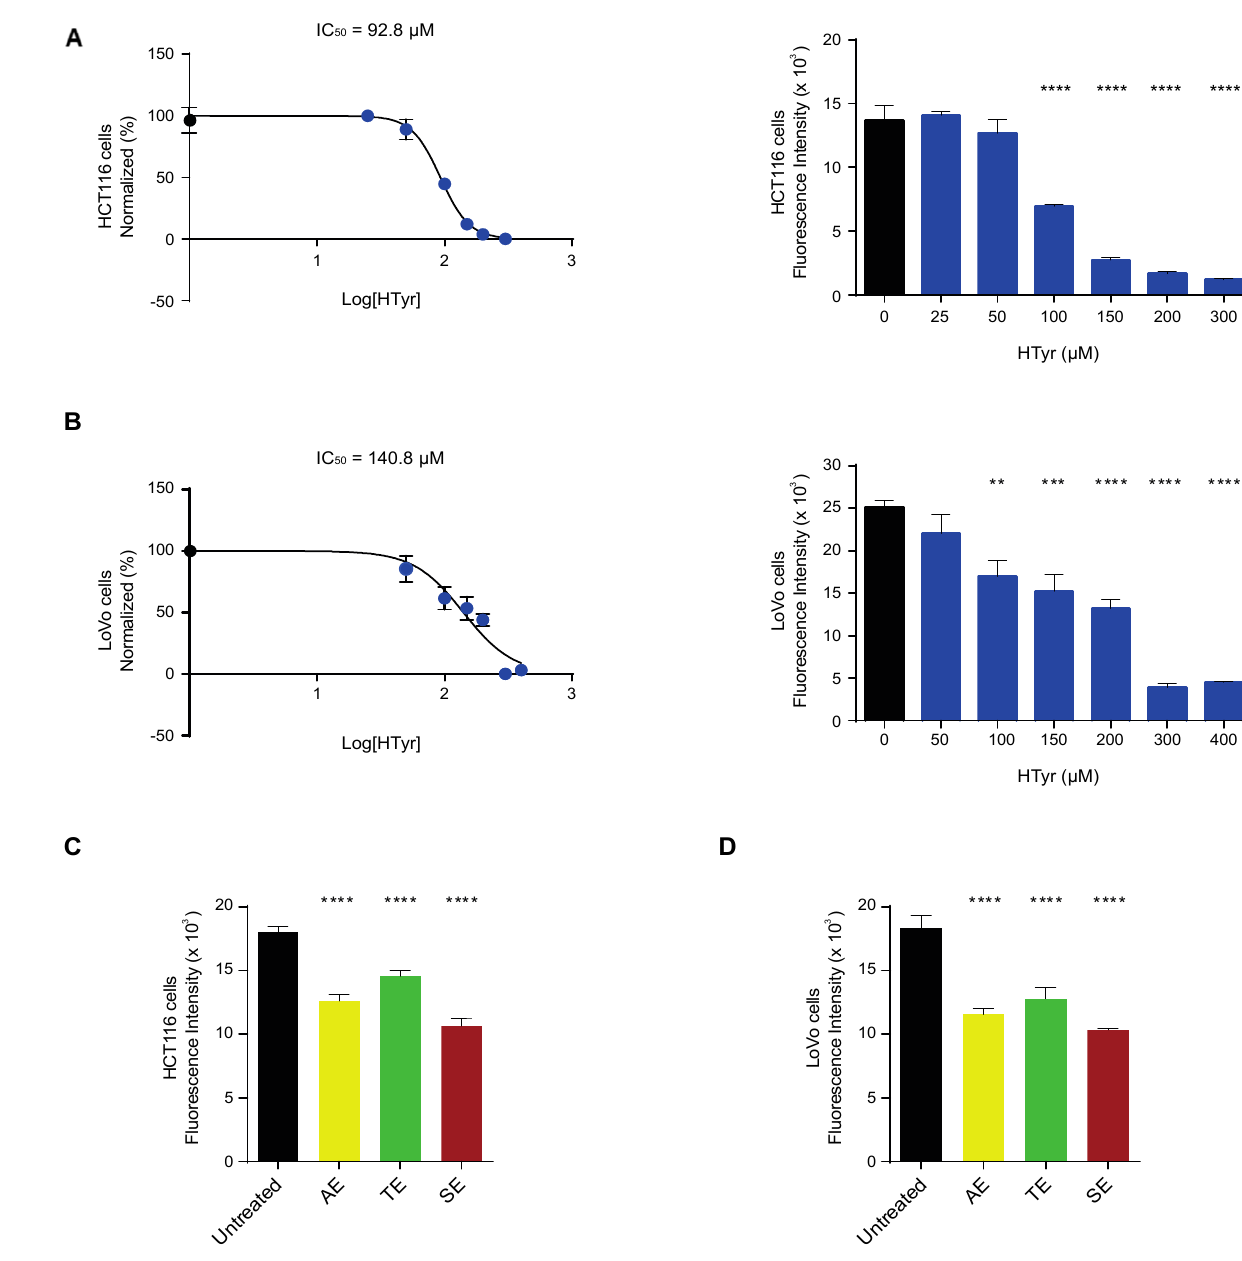
Figure 2. Hydroxytyrosol and OPWPs extracts influence colorectal cancer cells viability: ( A ) Cell viability of HCT116 cells treated with increasing concentrations of HTyr (from 0 to 300 μ M) for 72 h assessed by fluorescence intensity and reported here transformed in a log scale or as histograms. ( B ) Cell viability of LoVo cells treated with increasing concentrations of HTyr (from 0 to 400 μ M) for 72 h assessed by fluorescence intensity and reported here transformed in a log scale or as histograms. ( C ) Cell viability of HCT116 cells treated with 0.0154 mg mL − 1 OPWPs extracts for 72 h assessed by fluorescence intensity and reported as histograms. ( D ) Cell viability of LoVo cells treated with 0.0231 mg mL − 1 OPWPs extracts for 72 h assessed by fluorescence intensity and reported as histograms. Statistical significance is considered when ** p ≤ 0.01, *** p ≤ 0.001, **** p ≤ 0.0001 (ANOVA with Dunnett’s post-test).